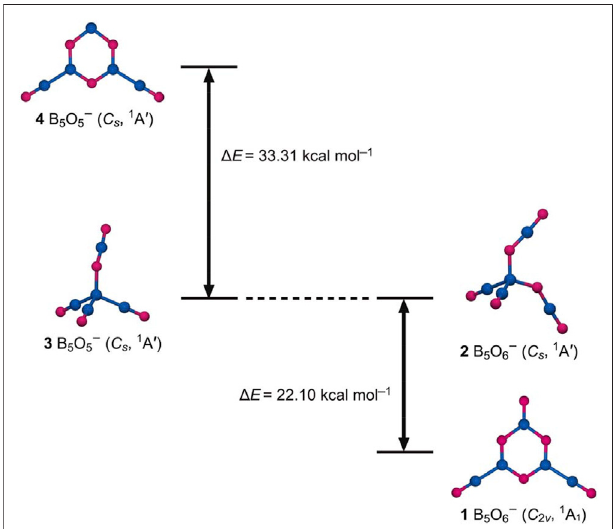
FIGURE1| Globalminimum(GM)structureofB 5 O 6 − (1, C 2 v , 1 A 1 )cluster and a representative 2 ( C s , 1 A ′ ) isomer. They feature a heterocyclic hexagonal B 3 O 3 ring and a tetrahedral B center, respectively. Relevant structures 3/4 of B 5 O 5 − cluster (left panels) show a distinctly reversed energy order. The relative energies are shown in kcal mol − 1 at the PBE0/6-311+G(d)